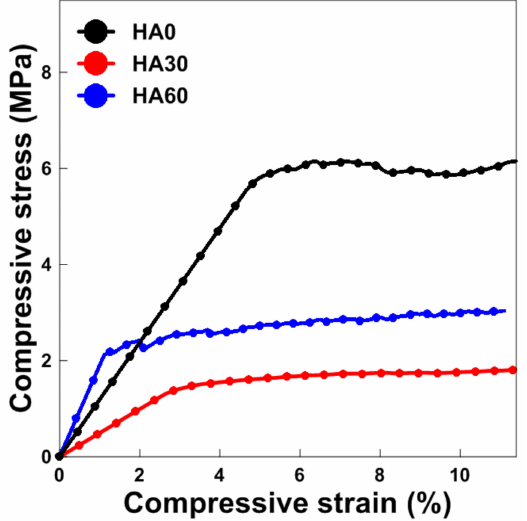
Figure 9. Compressive stress–strain curve for the HA sca ff